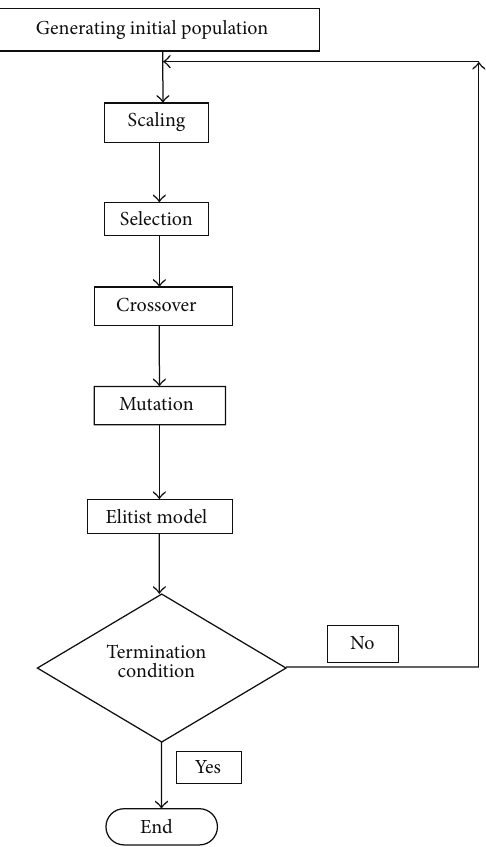
Figure 4: Flow chart of genetic algorithm.